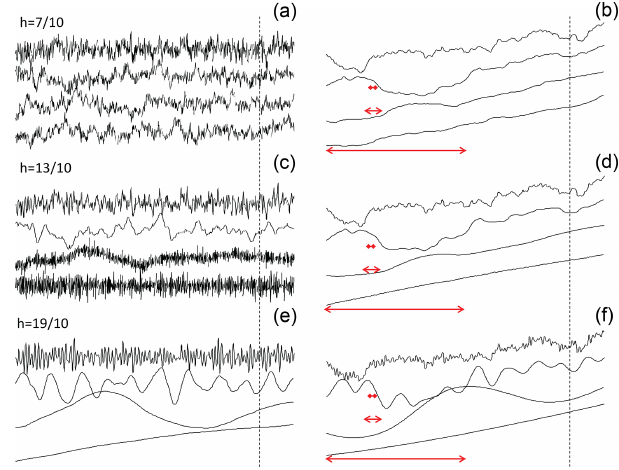
Figure 7. The same as Fig. 6 but for h = 7 / 10, 13 / 10 and 19 / 10 (top to bottom). Over this range, the top (large-scale, degraded- resolution) series is close to a white noise (a, c, e) and Brownian motion (b, d, f) . For the bottom series, there is no equivalent fGn or fBm process and the curves become smoother, although the rescal- ing may hide this somewhat (see for example the middle h = 13 / 20 set, the blow-up of the far-right 1 / 8 of the second series from the top shown in the third line). Also note for the bottom two sets with 1 < h < 2 the oscillations that have frequency 2 π/ sin (π/h) : this is the fractional oscillation